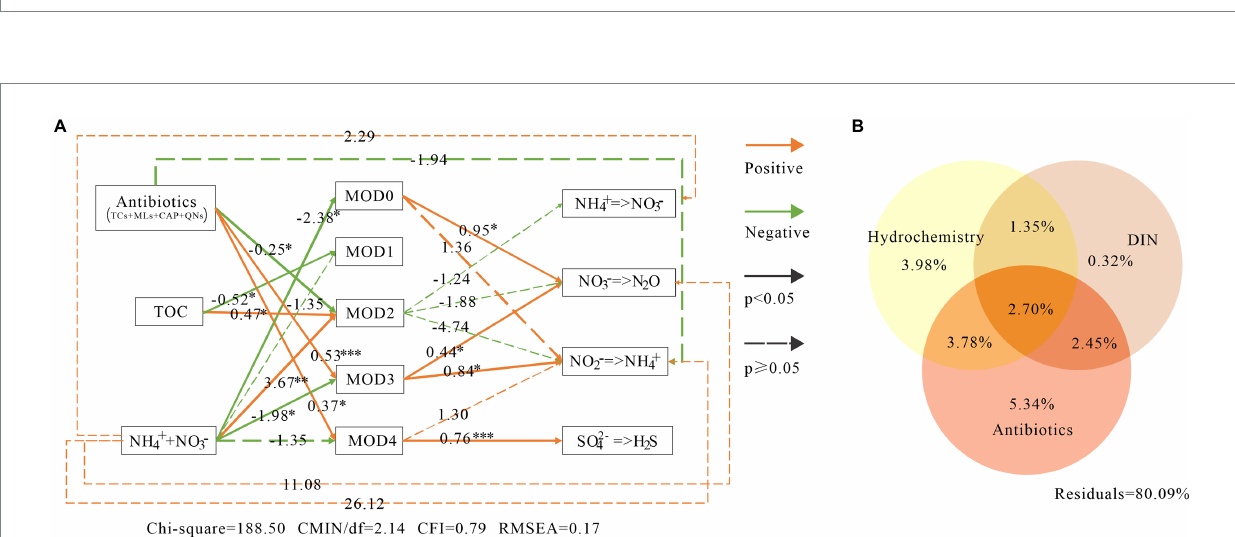
FIGURE 8 The environmental impacts on bacterial communities and their metabolic function in karst river. (A) Structure equation model (SEM) among environmental factors, modules and metabolic functions. Antibiotics were including tetracyclines, macrolides, chloramphenicol and quinolones. Green lines, orange lines indicated negative and positive impacts, respectively, and the associated numbers were the path coefficient value with p-values * p < 0.05, ** p < 0.01, *** p < 0.001. (B) Variance partitioning analysis (VPA) diagram. The impact of antibiotics, DIN and hydrochemical factors on microbial communities. DIN included ammonium, nitrate and nitrite. Antibiotics included quinolones, lincomycin, tetracyclines, macrolides, sulfonamides and chloramphenicol. Hydrochemistry included temperature, pH, electronic conductivity, dissolved oxygen and total organic carbon.